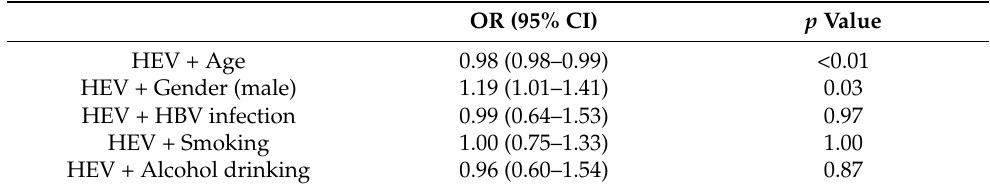
Table 3. Multiplicative interaction between HEV and other cancer risk factors in all cancer patients.